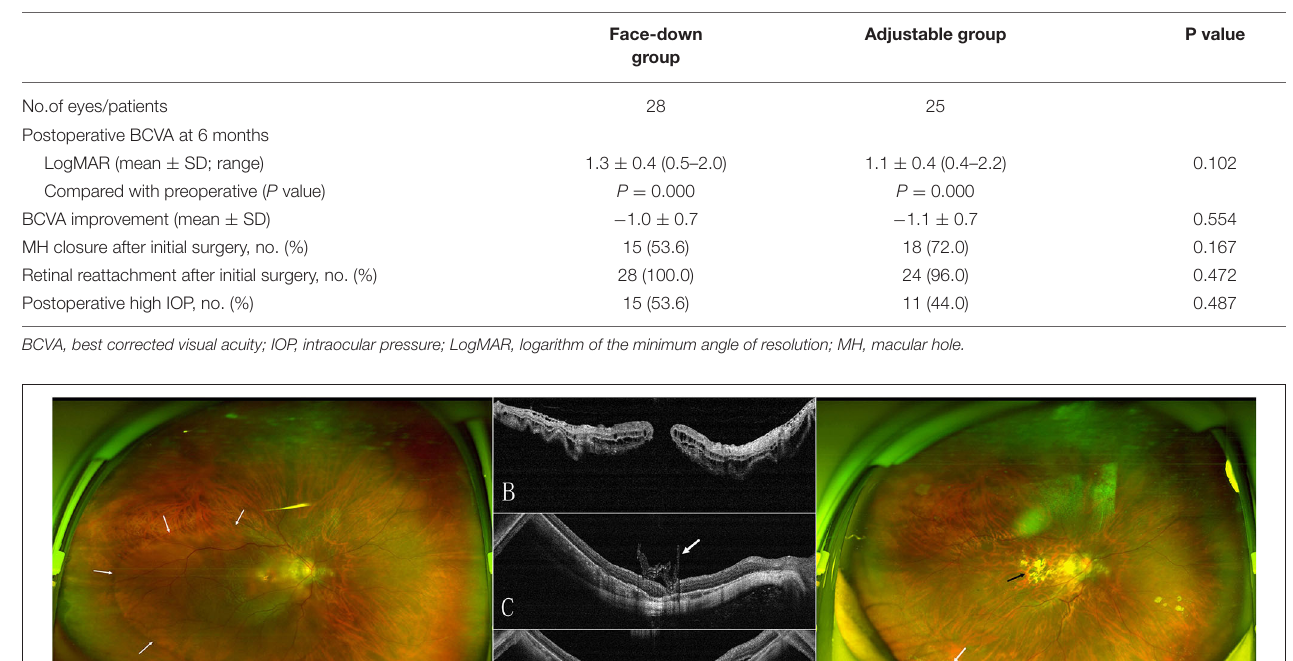
Face-down group